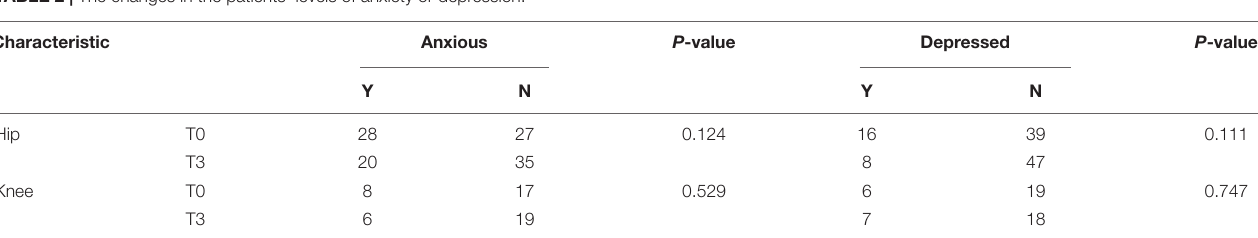
TABLE 2 | The changes in the patients’ levels of anxiety or